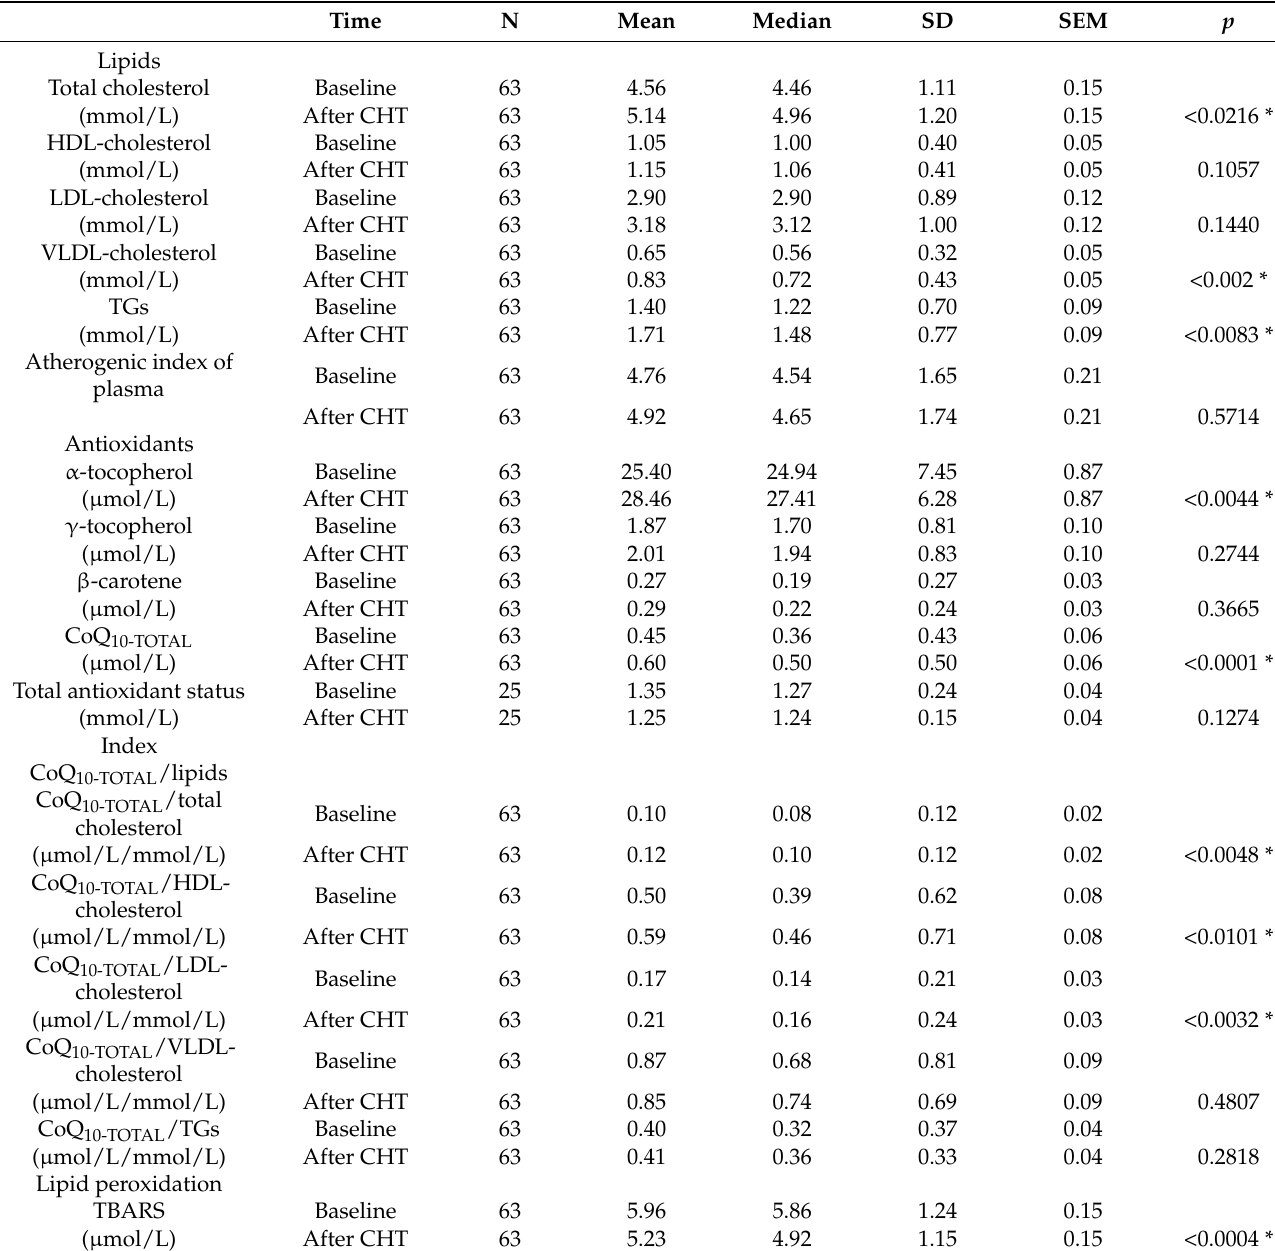
Table 1. Plasma lipids, antioxidants, index CoQ 10-TOTAL /lipids, and oxidative stress during chemotherapy in metastatic urothelial carcinoma patients (mUC). N: number of patients; SD: standard deviation; SEM: standard error mean; HDL: high-density lipoprotein; LDL: low-density